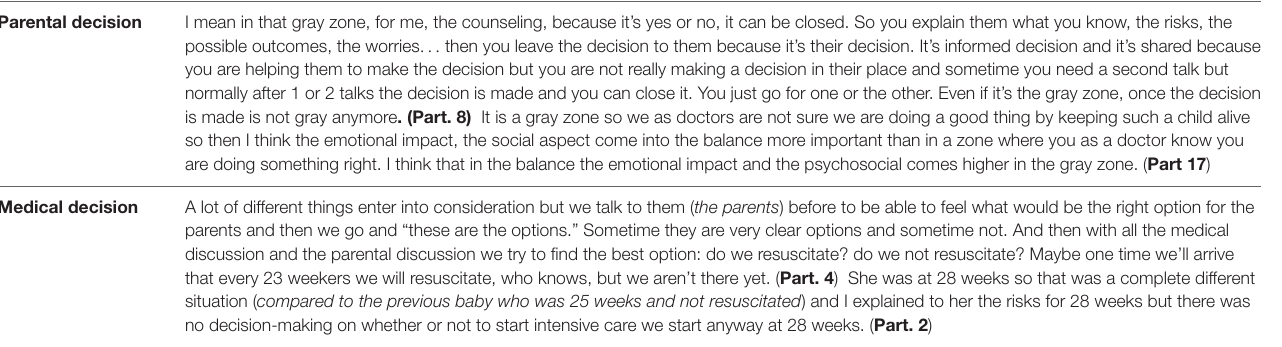
TABLE 4 | Illustrative quotes: Clinical-ethical decision-making, perceptions of decision-making and counseling a . Parental